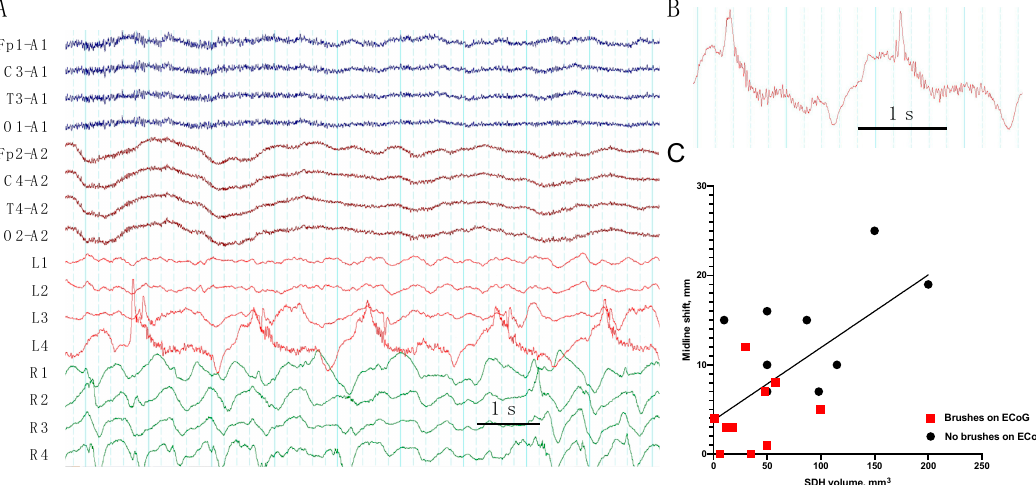
Figure 4. ( A ) Periodic discharges with the “brushes” on day 3 after TBI in patient #9. Periodic discharges with frequency 0.5 (complexes / sec) accompanied by fast (30–33 Hz) activity are evident on invasive ECoG (electrode L4); ( B ) The brushes from L4 electrodes; ( C ) Midline shift on CT correlates with subdural hematoma (SDH) volume ( p < 0.005), the brushes appear in patients with low grade midline shift and SDH volume ( p < 0.05, see text), n = 21.